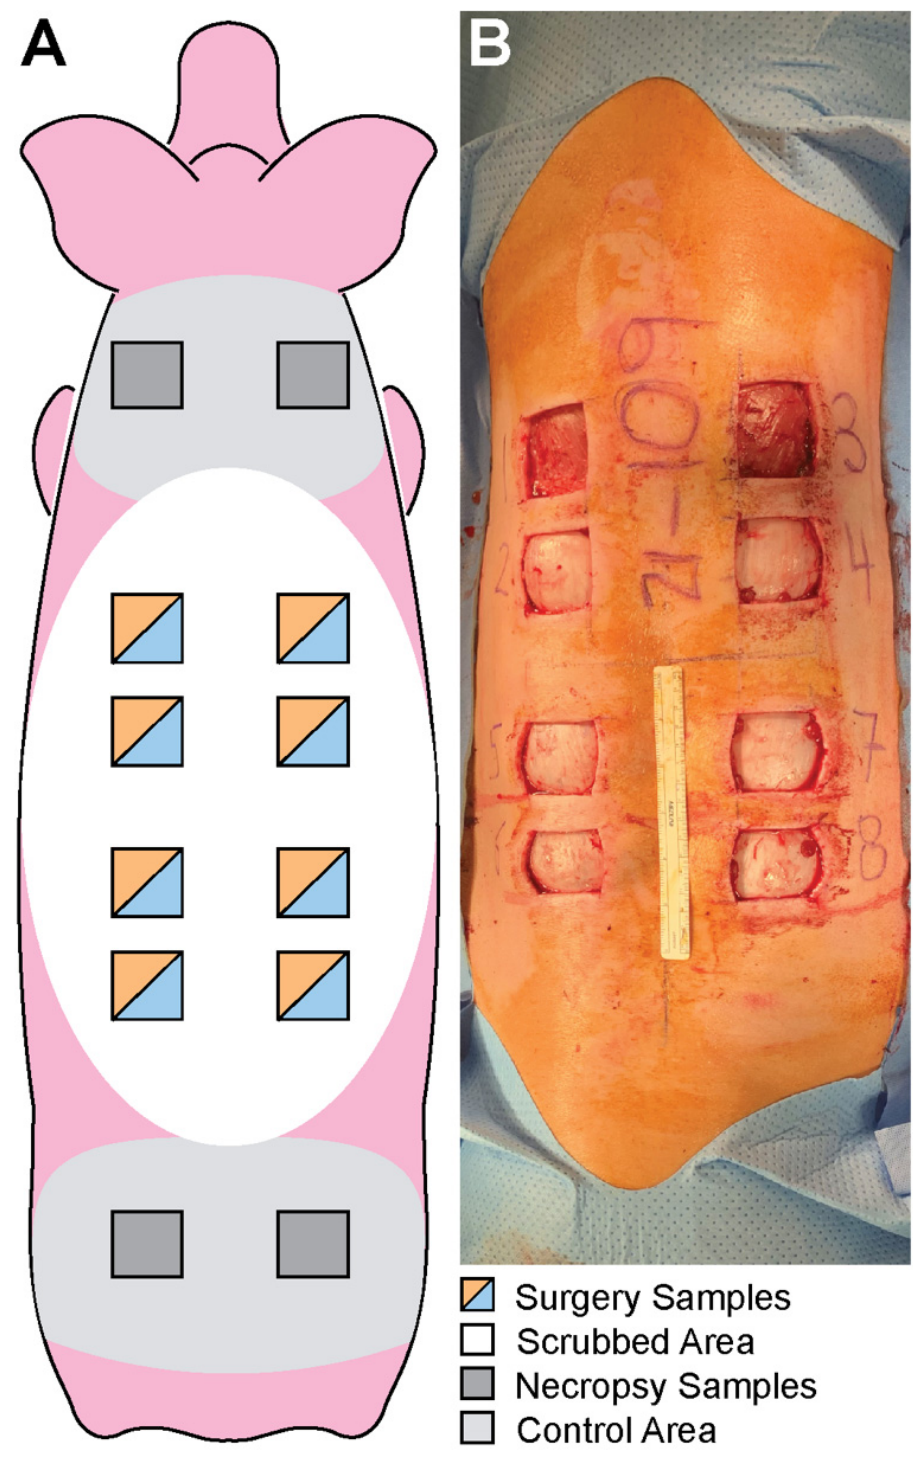
Figure 2. ( A ) Diagrams of the anatomical location of the skin preparation, control area, and the respective skin samples collected. ( B ) Dorsal view of surgery with the skin samples removed after PSP. Samples were cut 3 cm away horizontally from the spine and at least 2 cm apart.